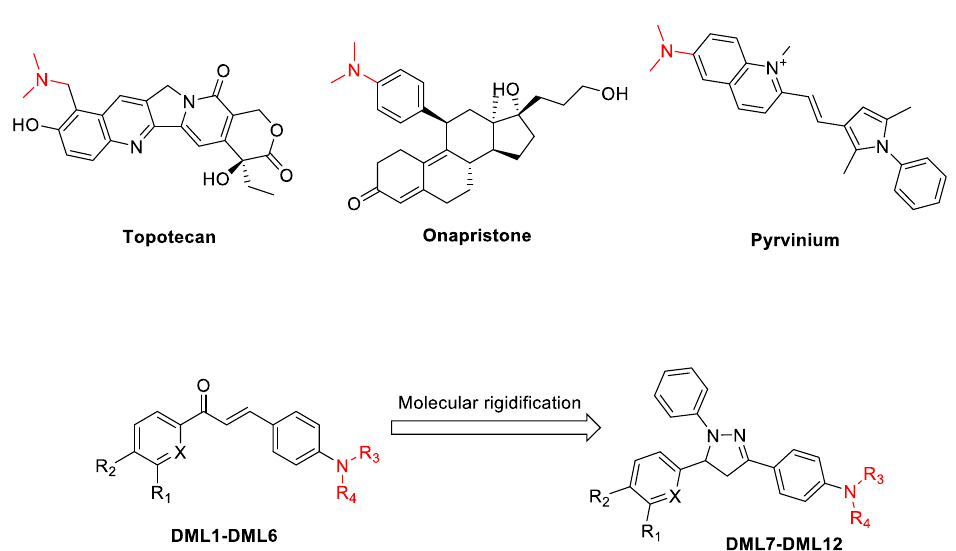
Figure 1. Representative structures of chalcone, dihydropyrazoles and dimethylamine functionalized-derived anticancer compounds.